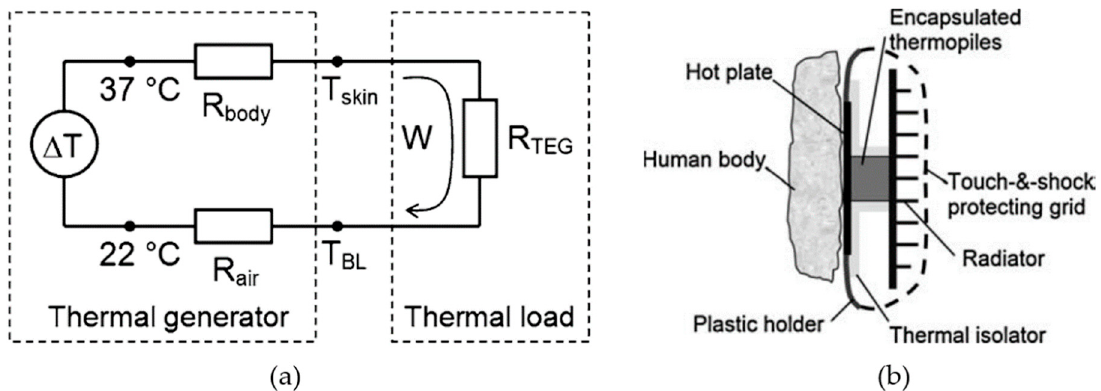
Figure 19. ( a ) Thermal circuit with generator and load; ( b ) TEG with radiator [110].